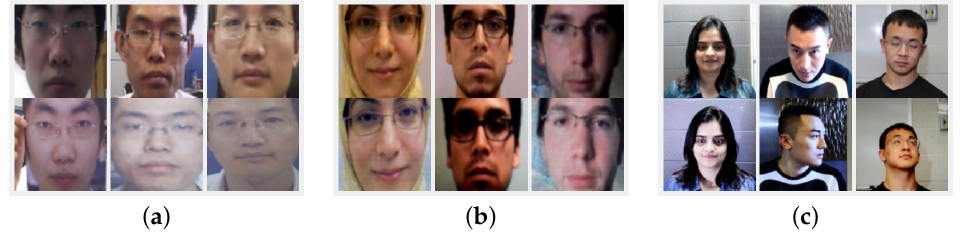
Figure 5. Real and fake facial image samples from ( a ) CASIA, ( b ) Replay Attack, and ( c ) SiW. Upper row in each figure contains the real-face samples, whereas the lower row has the PA